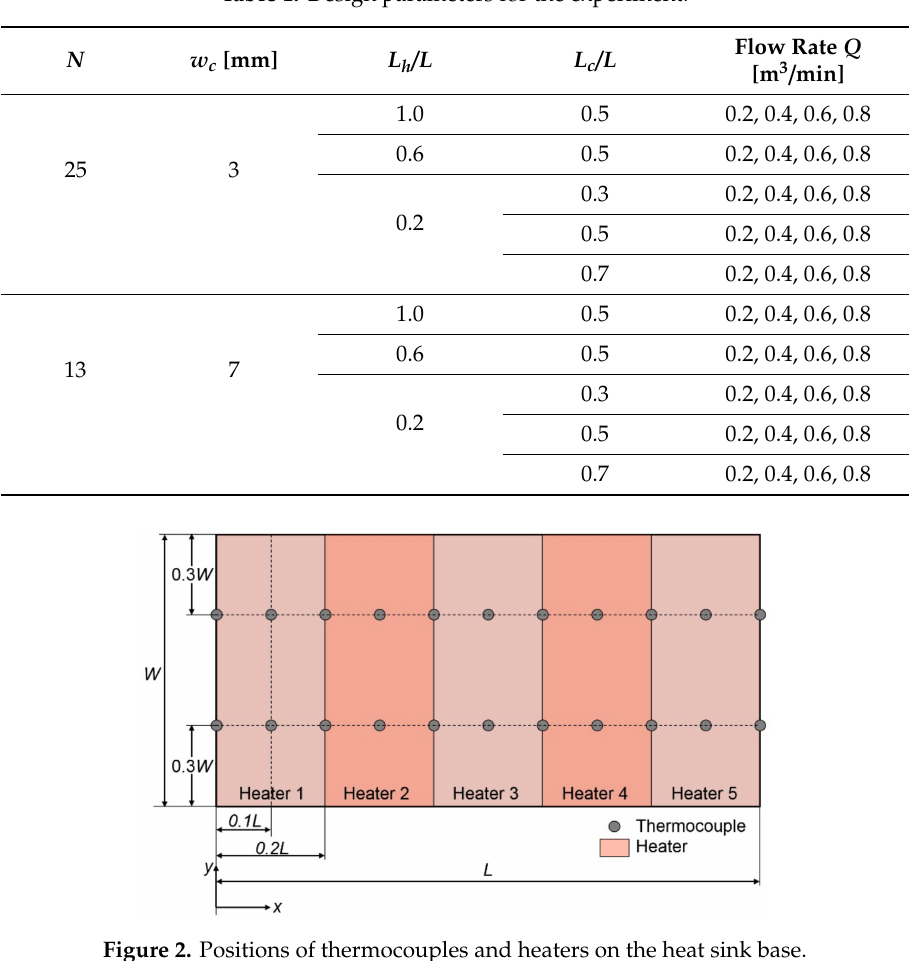
Figure 2. Positions of thermocouples and heaters on the heat sink base.